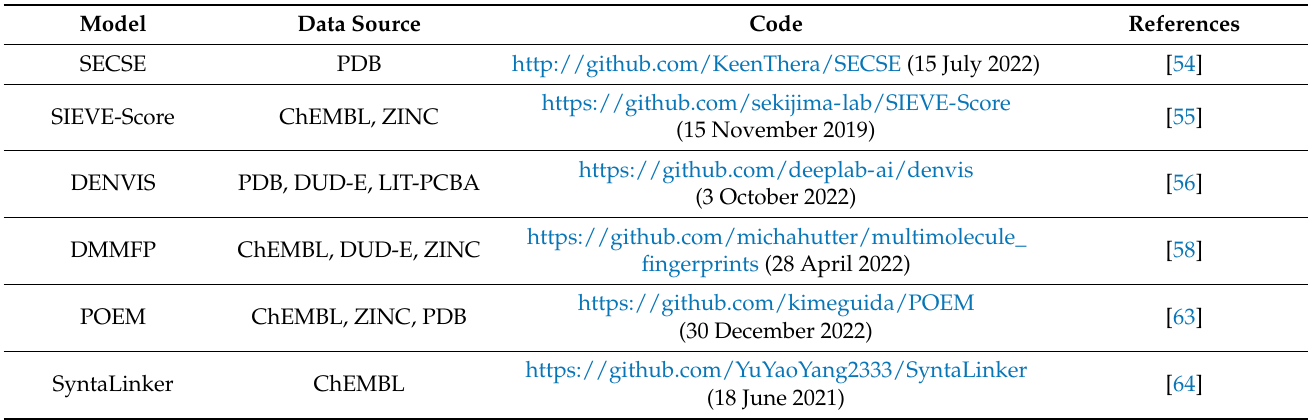
Table 3. Artificial intelligence-based screening methods of anti-cancer drug hit